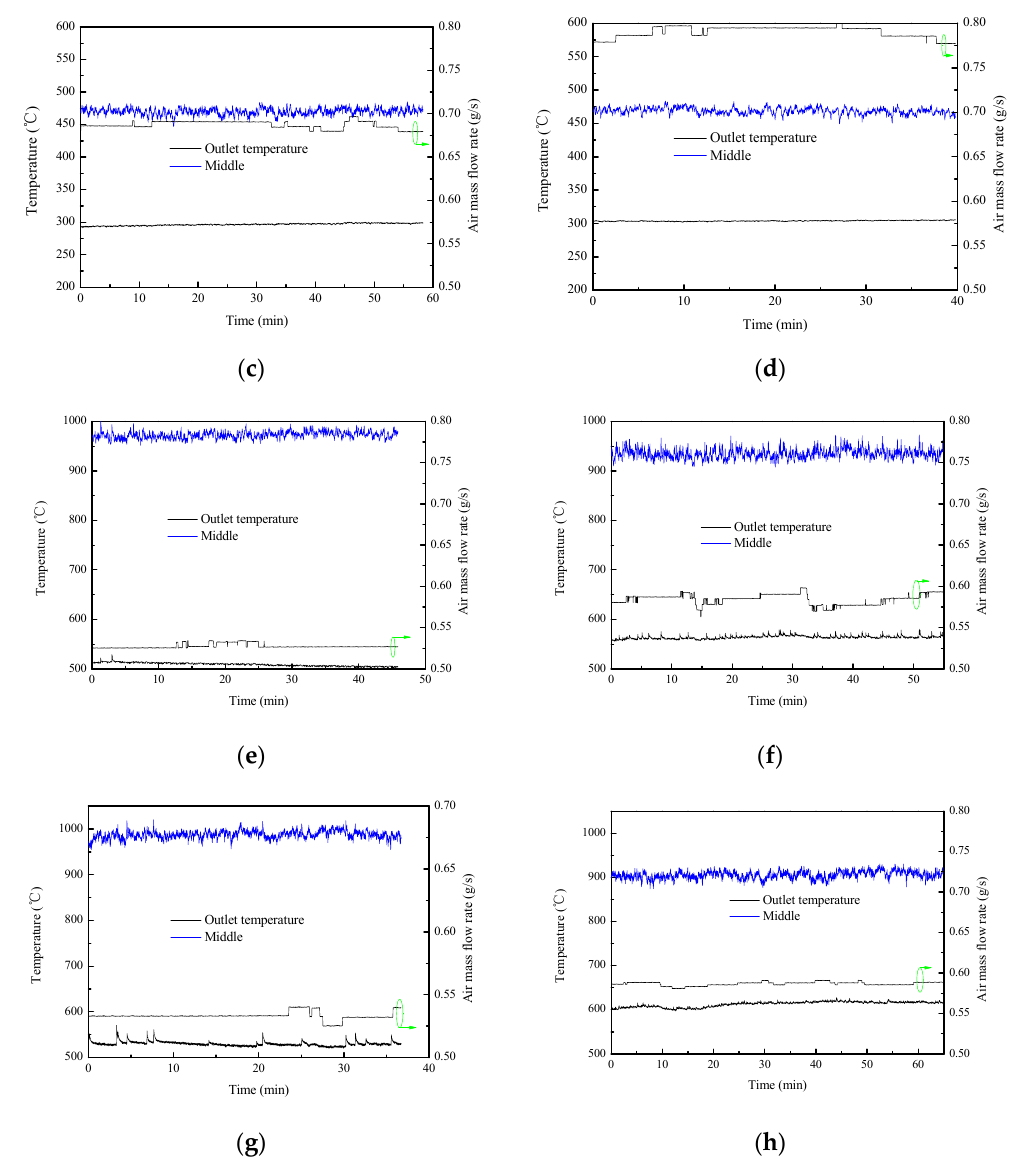
Figure 6. The fluidized heat absorption inside the quartz tube. ( a ) Case 5; ( b ) Case 6; ( c ) Case 7; ( d ) Case 8; ( e ) Case 9; ( f ) Case 10; ( g ) Case 11; ( h ) Case 12.